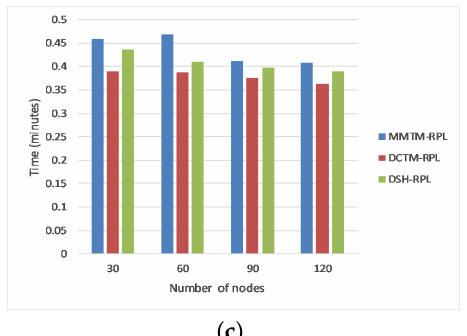
Figure 4. Comparison of network lifetime for different attacks: ( a ) Rank attack, ( b ) Sybil attack, and ( c ) Sinkhole attack.